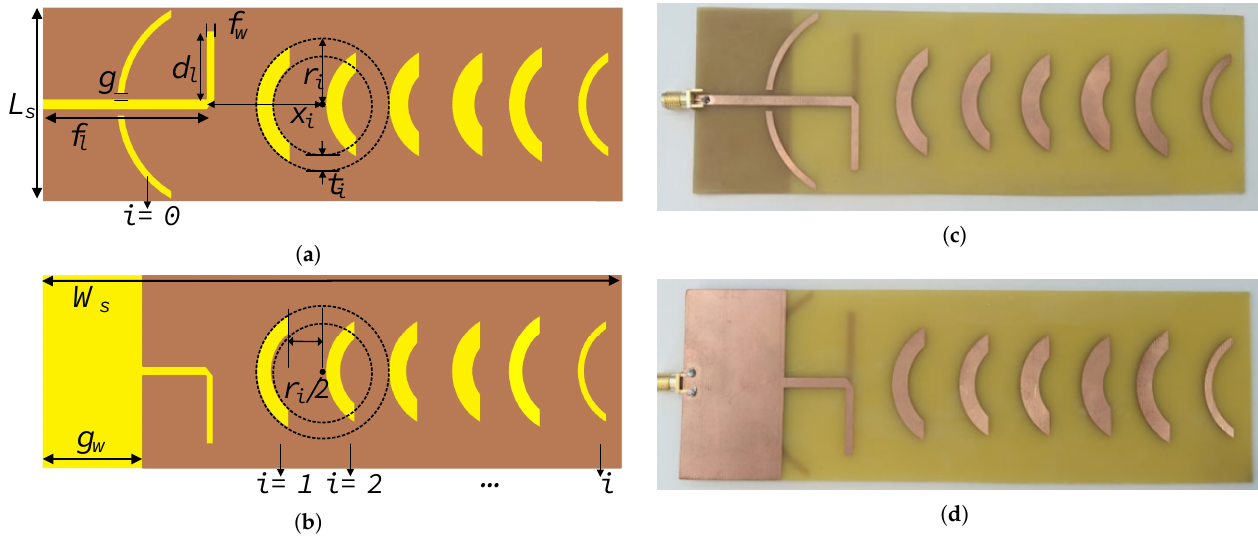
Figure 2. Microstrip waning crescent Quasi-Yagi: ( a ) top and ( b ) bottom antenna layout; ( c ) top and ( d ) bottom views of the antenna prototype [overall dimensions: 185 × 60 mm 2